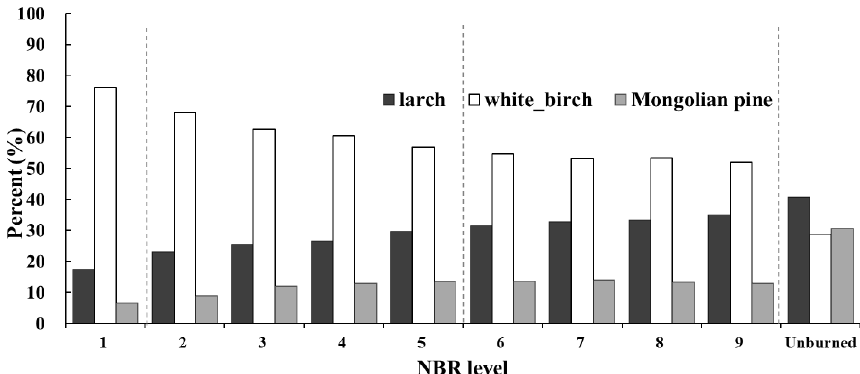
Figure 7. Tree species composition in forests under different fire intensities.